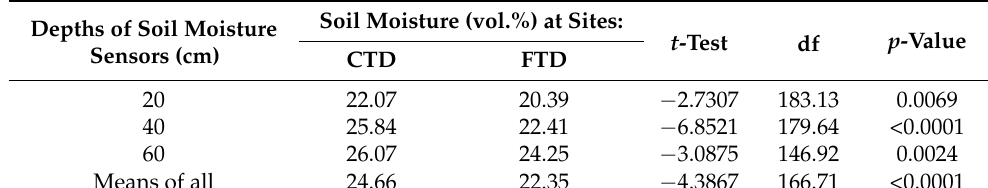
Table 4. Mean soil moisture from each and all depths and Welch ´ s test parameters ( t -test, degrees of freedom df, p -value) at CTD and FTD sites.